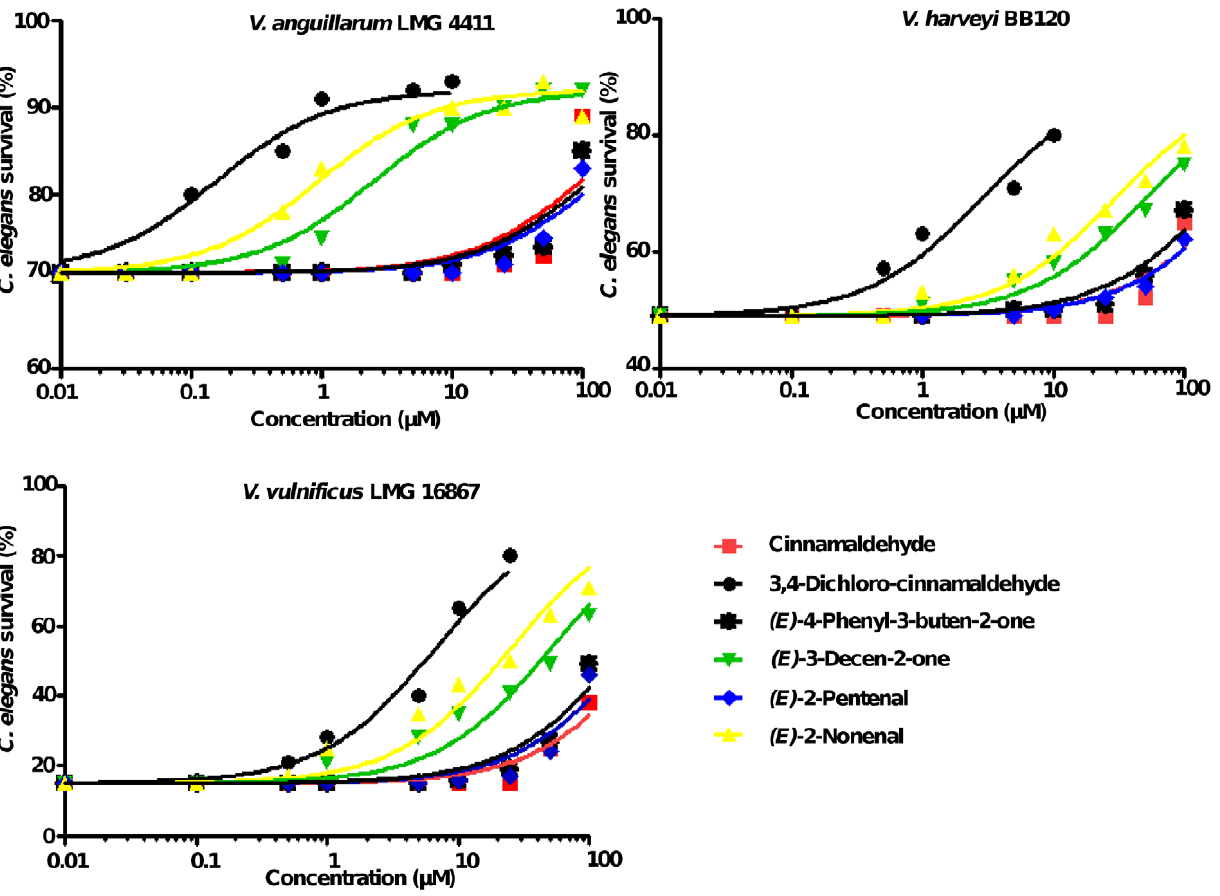
Figure 3. Survival curves after infection of C.elegans with V.anguillarum LMG 4411, V.harveyi BB120 or V.vulnificus LMG 16867 in the presence or absence of QS inhibitors.